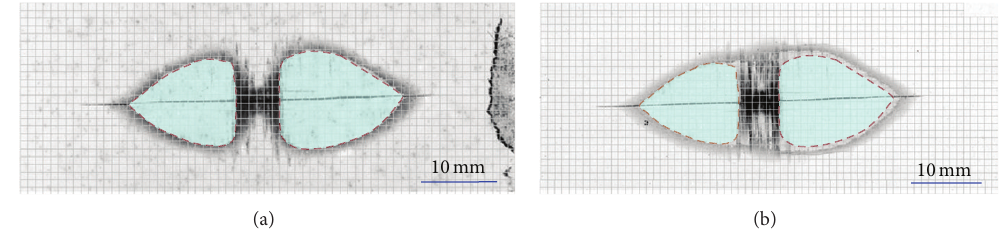
Figure 9: X-radiographs of specimen before (a) and after (b)